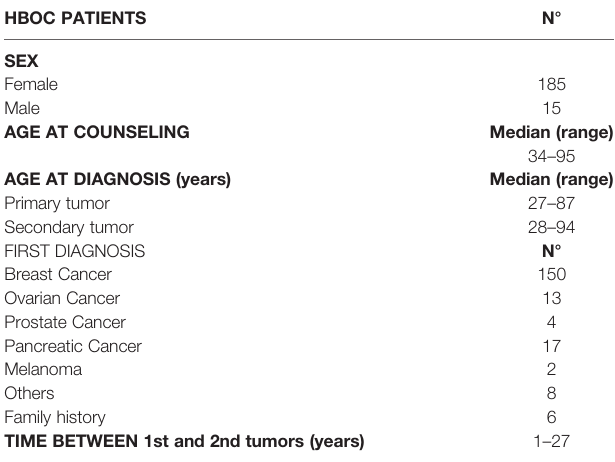
TABLE 1 | Clinical characteristics of HBOC